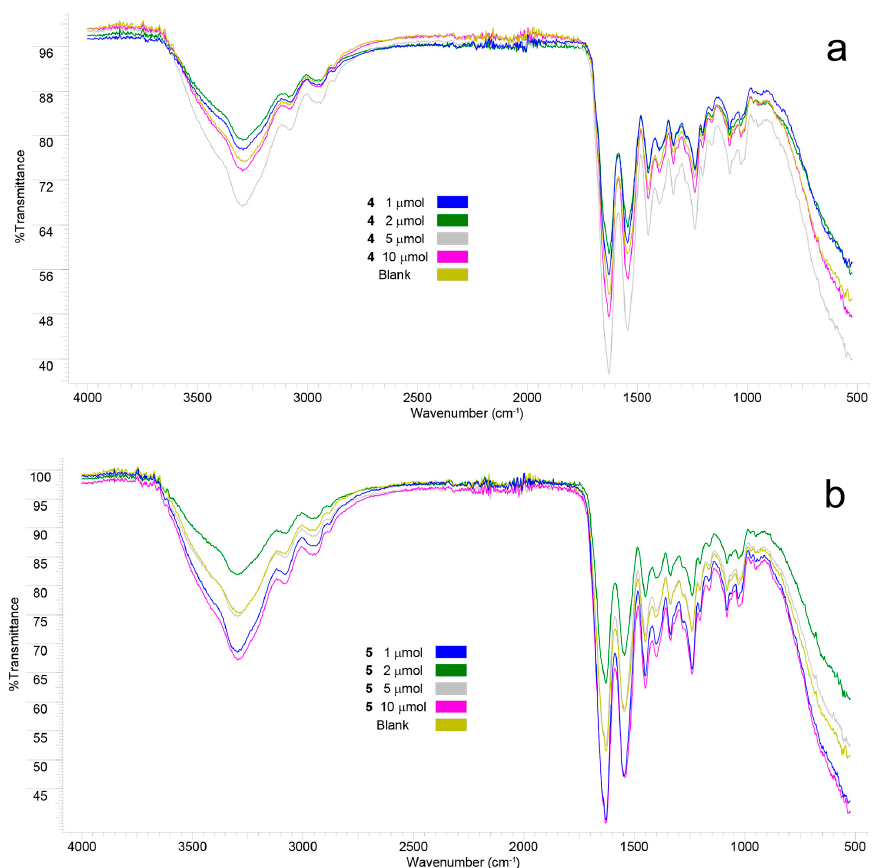
Figure 4. ATR-FTIR spectra of dry gelatins treated with 4 ( a ) and 5 ( b ). Similarly, changes were almost never detected by 1 H NMR analysis in the D 2 O